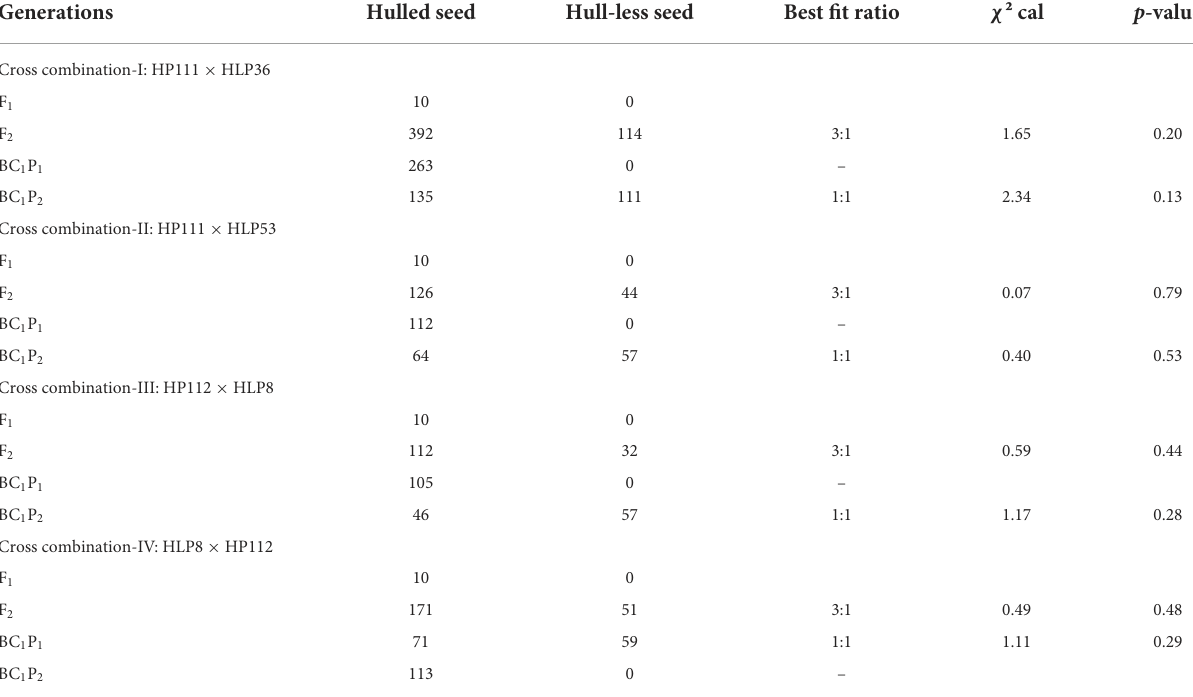
TABLE 1 Segregation of hulled and hull-less seed trait in different crosses. Generations Hulled seed Hull-less seed Best fit ratio χ ² cal p -value